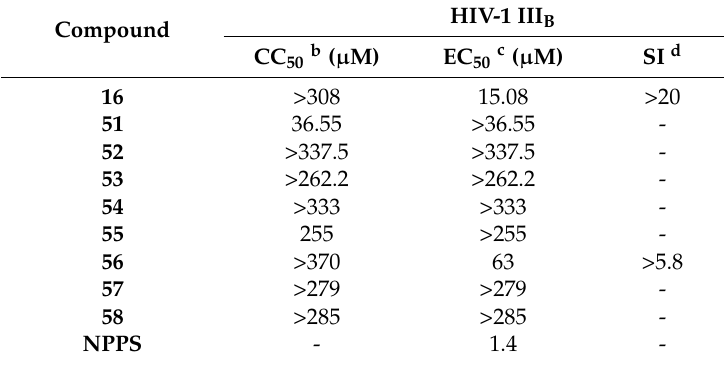
Table 4. Anti-HIV-1 Activity of PASs 16 and 51 – 58 a